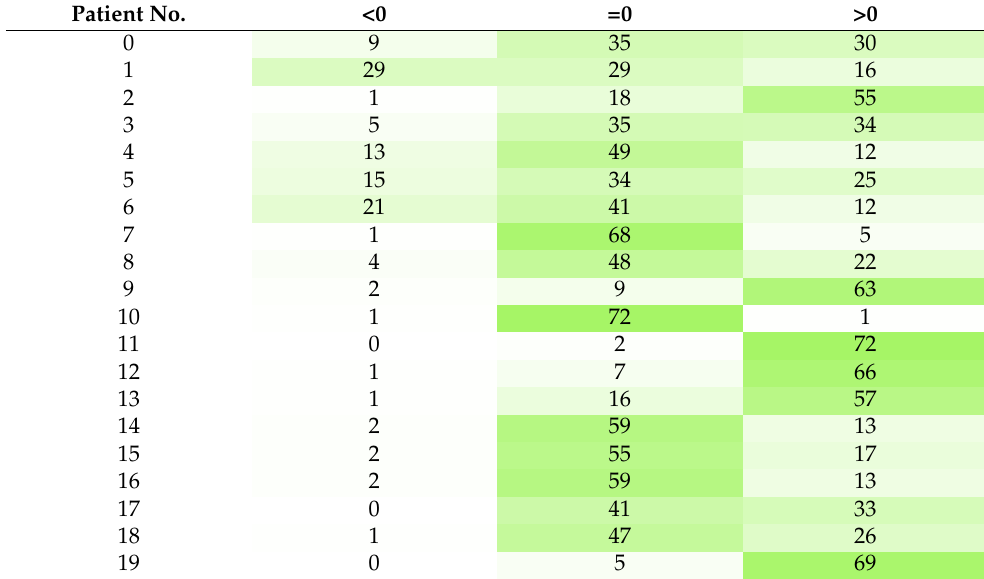
Table 4. Changes in the answers by patient. Every row represents a questionnaire; columns represent negative, natural, or positive change.